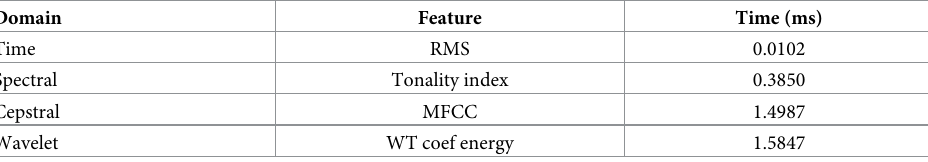
Table 8. Features with fastest average computation time in each domain.